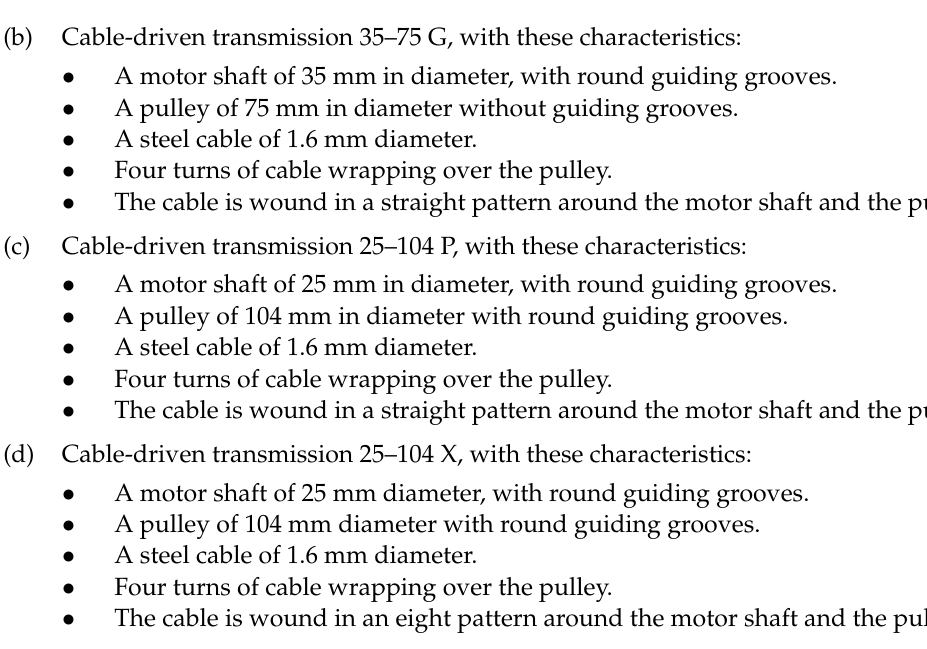
Figure 16. Cable-driven transmission 25–75